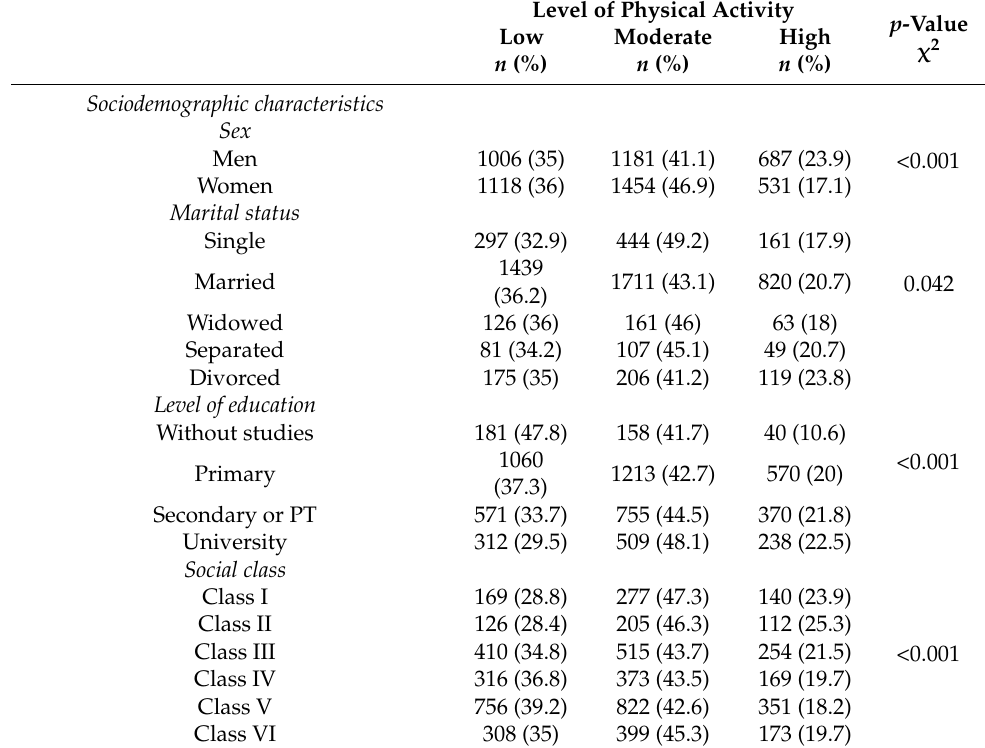
Figure 3. Distribution of levels of PA at depression and anxiety in Spanish pre-elderly ( n = 5977). Table 3. Characteristics of Spanish pre-elderly (age between 50 and 64 years old) by level of physical activity ( n =